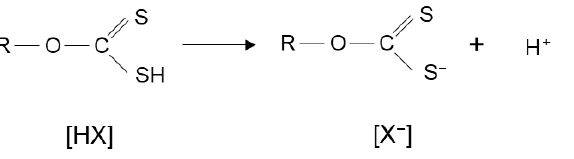
Figure 11. Formation of dixanthogen.